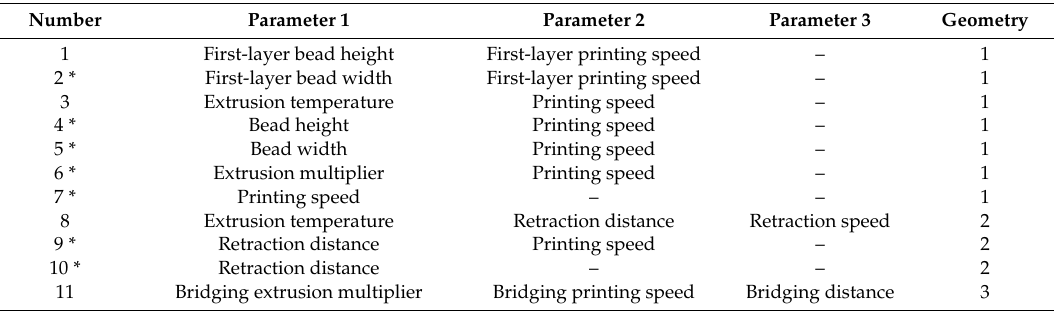
Table 1. The sequence of tests to optimize key processing parameters (PPs) in material-extrusion-based additive manufacturing MEAM. List of pairs or triples of key PPs and geometry type used in each test. The optional tests are marked with an asterisk